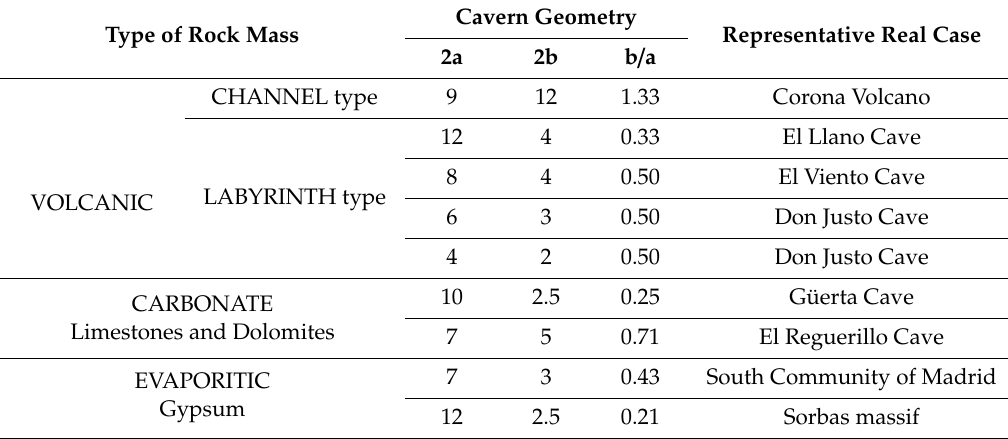
Table 1. Morphology of the most representative real cases of